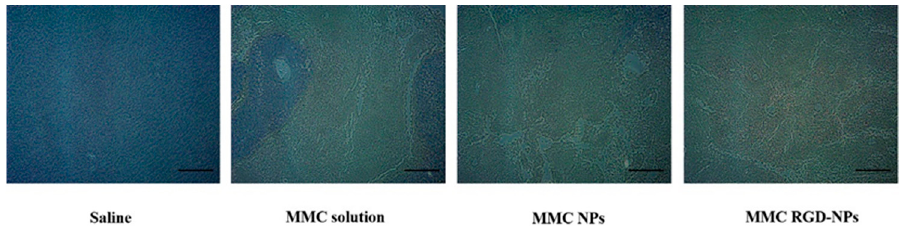
Figure 13. TUNEL assay of tumor tissues isolated from mice treated with saline, MMC solution, MMC NPs, MMC-RGD-NPs, and observed by optical microscope, 100×. Scale bar = 50 μ m.